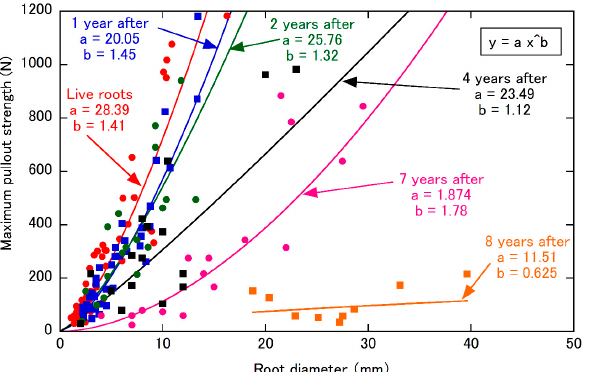
Figure 3. Maximum pullout strengths of the Japanese cedar roots of live trees and stumps cut at different times (labelled on the graph).